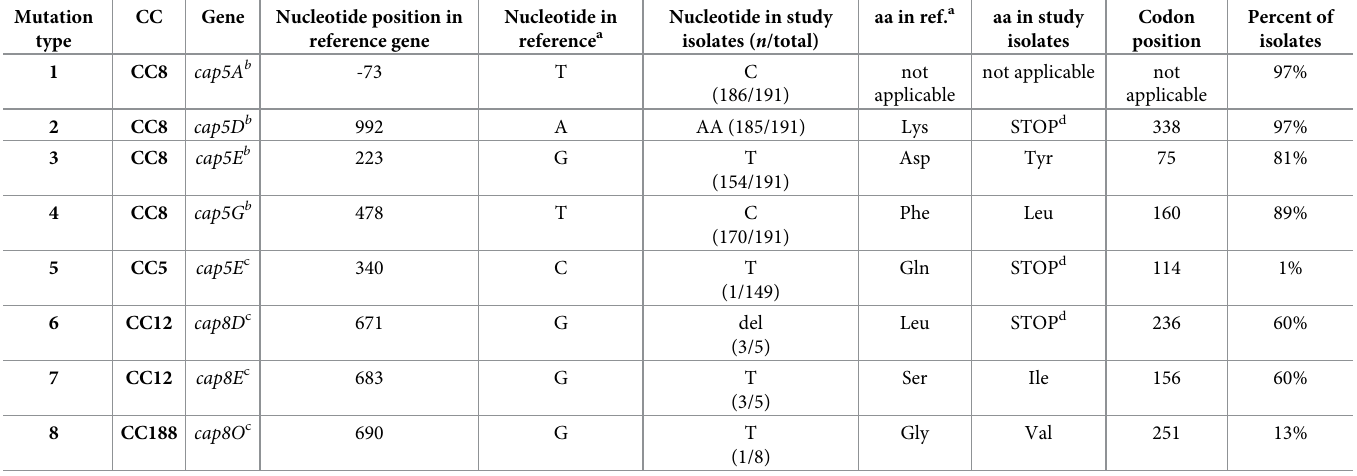
Table 3. Summary of cap operon SNPs and indels detected in the study isolates typed as belonging to CC5, 8, 12 and 188. Mutation